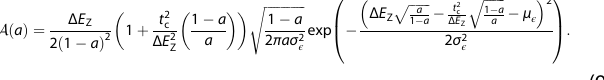
exponential (dark red). The region of exponential decay corre- sponds directly to when Fð ω Þ has been skewed asymmetrically as shown by the large charge-noise magnitude examples in Fig.